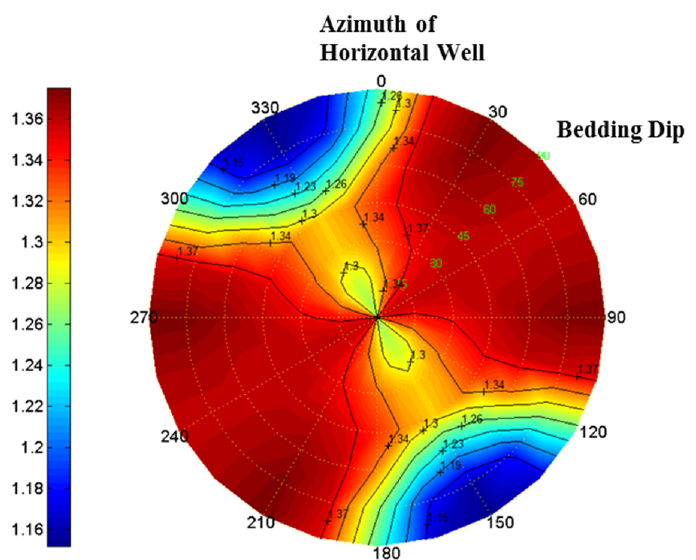
Figure 9. Collapse pressure of horizontal borehole for different well azimuths and dip angles of bedding planes (dip direction of bedding plane is at 150°; direction of the minimum horizontal stress is at 60°).